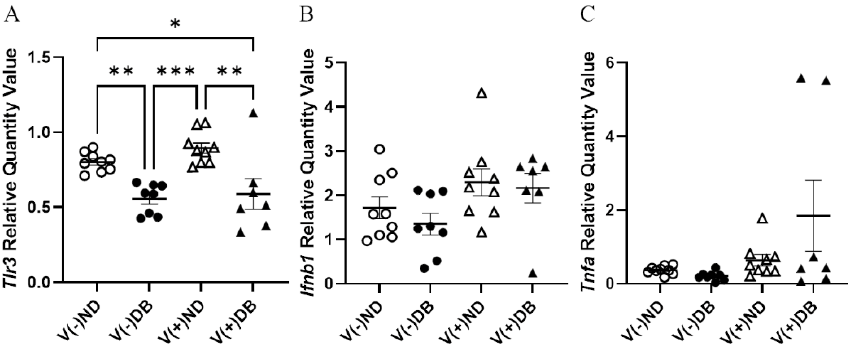
Figure 2. Body weight, kidney weight, and normalized kidney weight: ( A ) body weight, ( B ) kidney weight, and ( C ) normalized kidney weight were measured and compared across all four NOD mouse groups ( n = 7–9; * p < 0.05, ** p < 0.01, *** p < 0.001, **** p < 0.0001; V( − )ND, V( − )DB, V(+)ND,